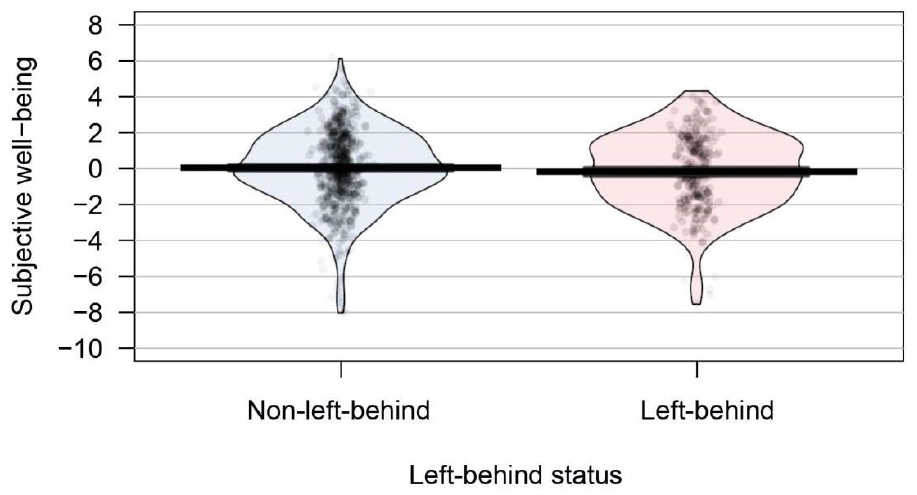
Figure 1. Group differences in subjective well-being. Note . N = 738. Points—Raw data; Bar/Line—Mean; Bean—Data distribution; Band—Confidence interval.